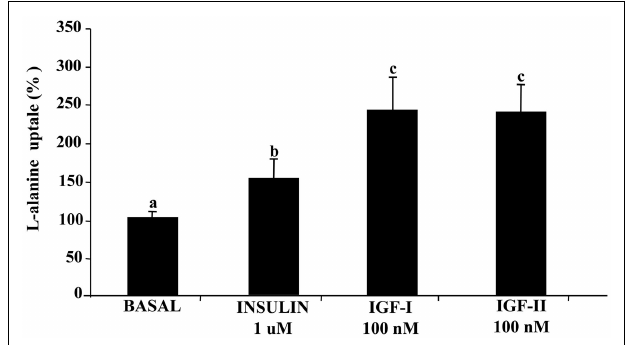
FIGURE 1 | Stimulation of L-alanine uptake by insulin, IGF-I, and IGF-II in sea bream myocytes. Cells at day 4 of in vitro development were incubated for 2h with IGF-I or IGF-II (both at 100nM) or insulin (1 μ M), and subsequently incubated with labeled L-alanine for 20 additional min. Results are expressed as percentage of stimulation above basal levels and mean ± SE ( n = 3 experiments). Statistical differences between conditions were analyzed by one-way ANOVA followed byTukey’s post hoc test. Different letters indicate significantly ( P < 0.05) different values among